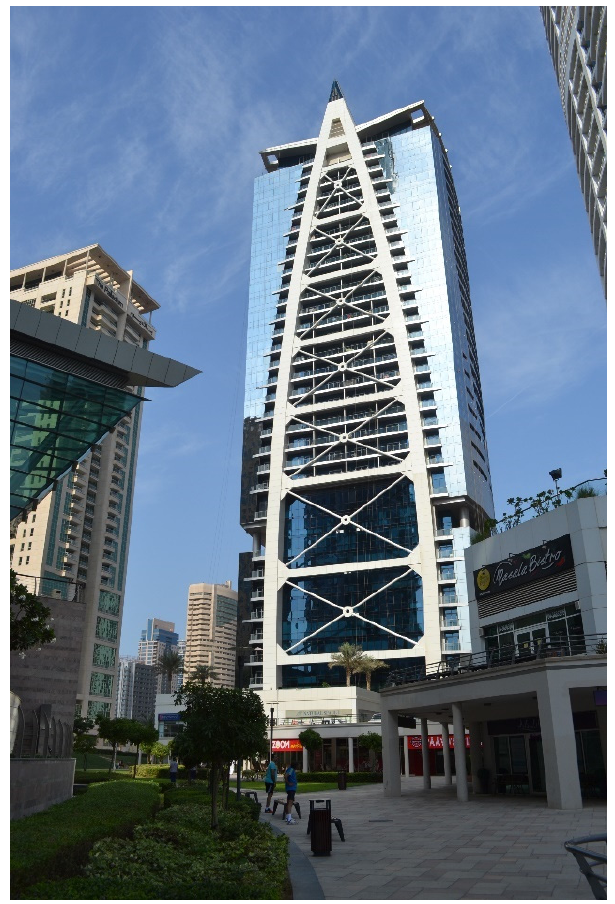
Figure 21. The Indigo Icon Tower (2009) in Dubai, UAE. (Photo by K. Al-Kodmany).